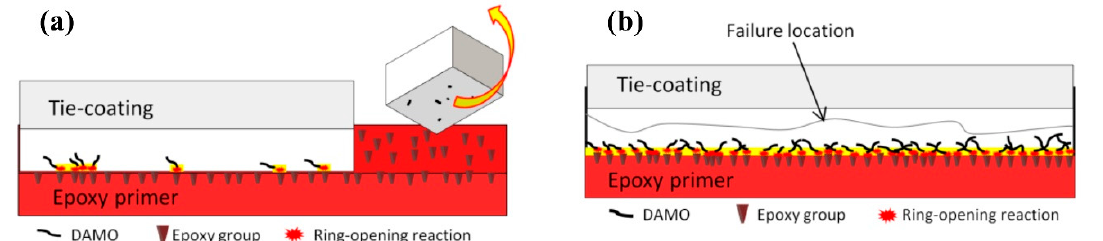
Figure 10. Schematic diagram of tie-coating failure: ( a ) interlaminar failure; ( b ) tie-coating fracture failure.